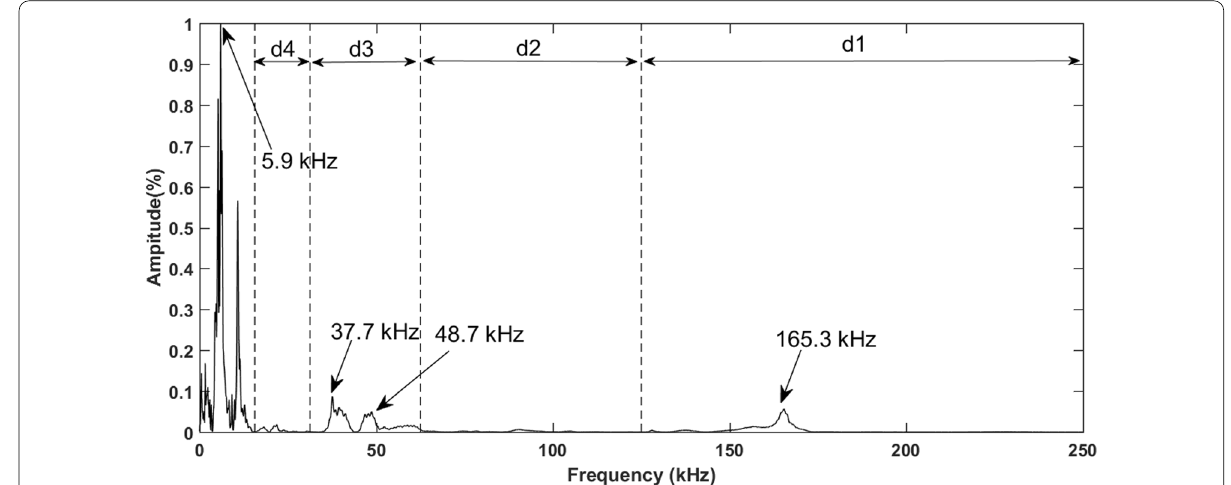
Table 1 Propagation velocity of the third layer surface wave under different boundary conditions